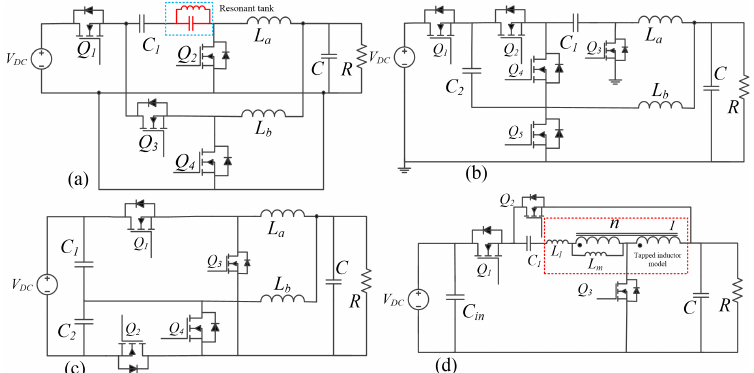
Figure 7. Extended or series-capacitor buck converter ( a ) with a resonant circuit, ( b ) gain exten- sion using an additional capacitor, ( c ) with an initial capacitor charging mechanism and ( d ) with a tapped-inductor.